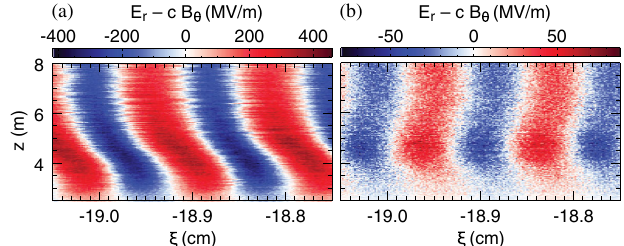
FIG. 12. Waterfall plots of E r − cB θ for ξ ≈ − 1 . 5 σ zb